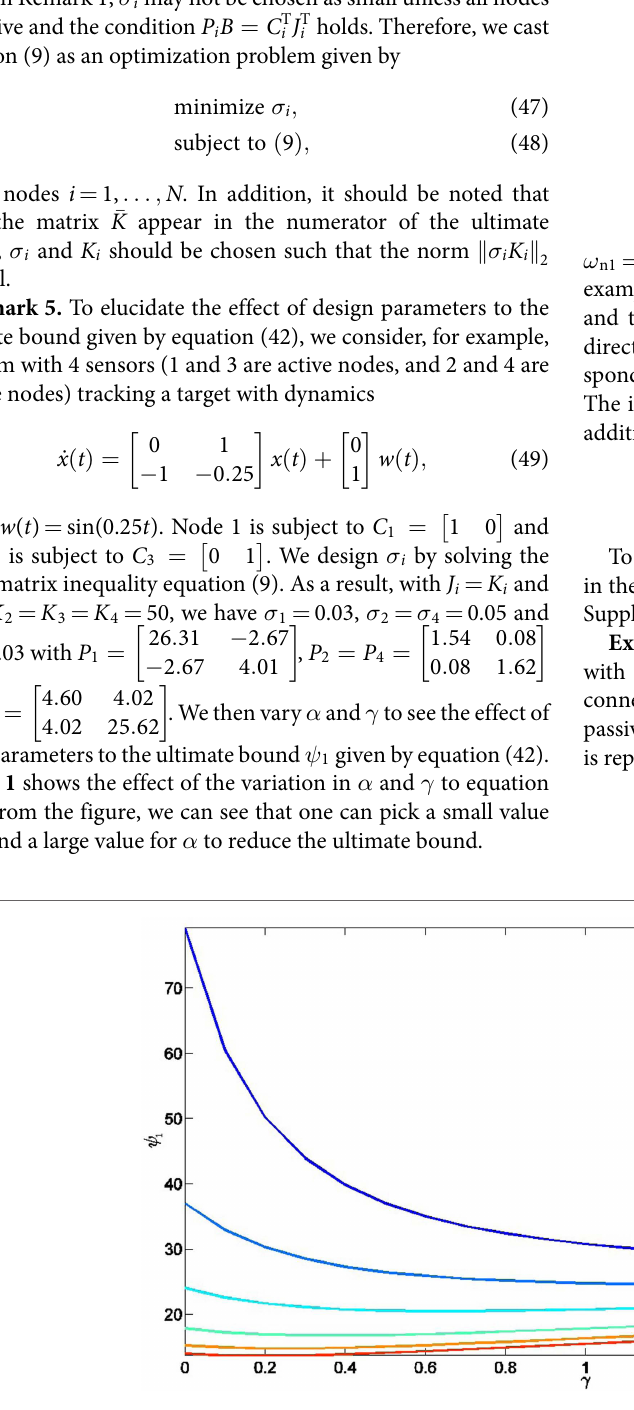
FIGURE 1 | Effect of (cid:13) 2 (0, 2] and (cid:11) 2 {0.25, 1, 2.5, 5, 10, 50} to the ultimate bound 1 in equation (42), where the arrow indicate the direction (cid:11) is increased.